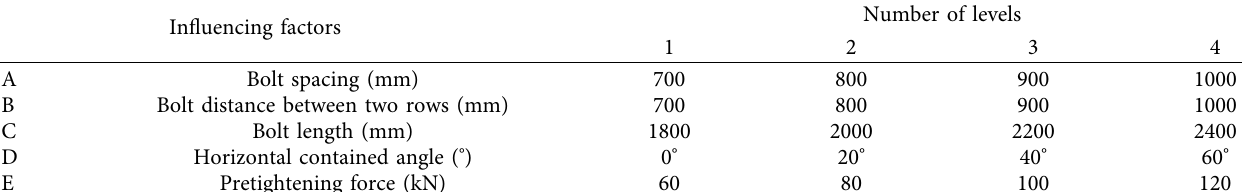
Table 1: Orthogonal experiment level design.